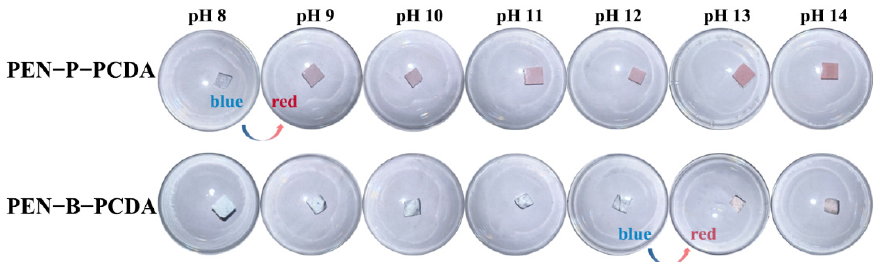
Figure 7. Photographic images of PEN − P − PCDA and PEN − B − PCDA nanofibrous membranes in reaction to various pH values under room temperature.